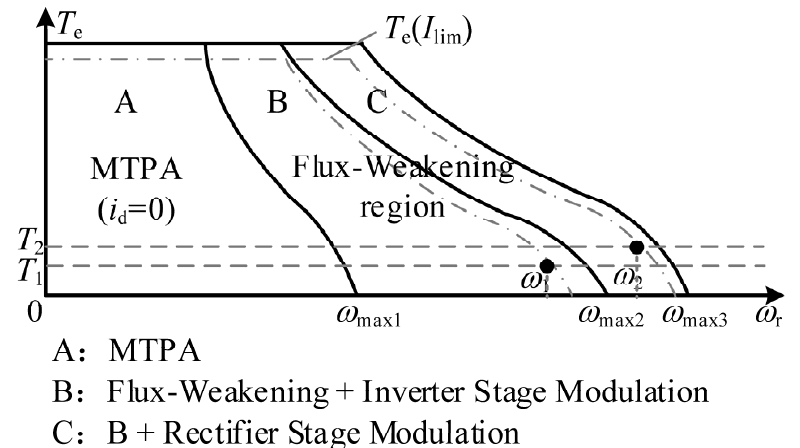
Figure 2. Schematic diagram of speed regulation range. Table 1. Control strategies or modulation methods activated in different regions.